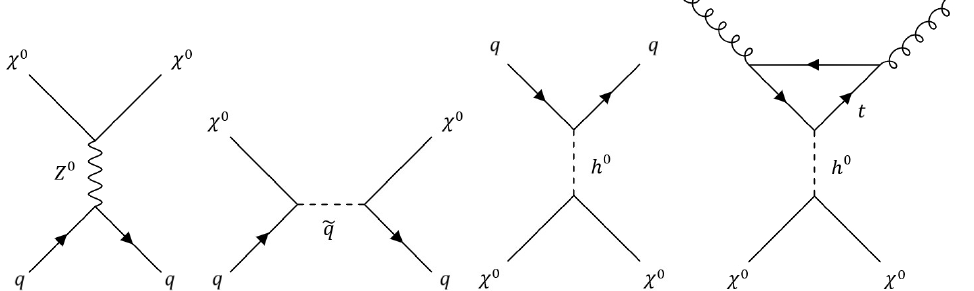
Figure 2. Left panels: Scattering off an atomic nucleus via Z 0 exchange and squark exchange occurs for neutralinos but not higgsons. Right panels: Scattering off an atomic nucleus via Higgs exchange leads to strong spin-independent scattering for natural neutralinos which are dominantly higgsino but have a significant gaugino admixture.